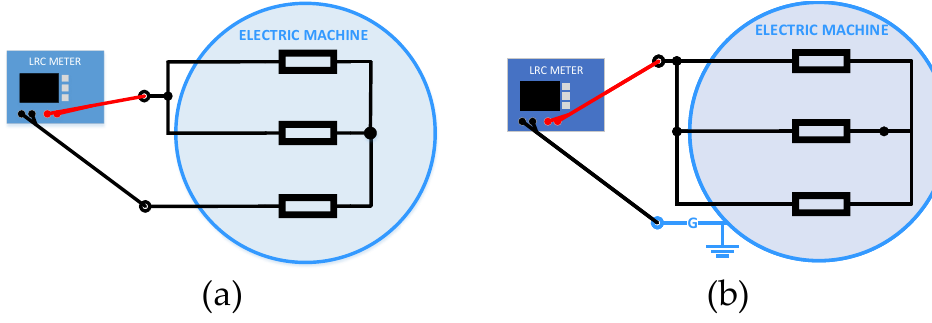
Figure 6. Impedance measurement connection layout. ( a ) CM; ( b ) DM.